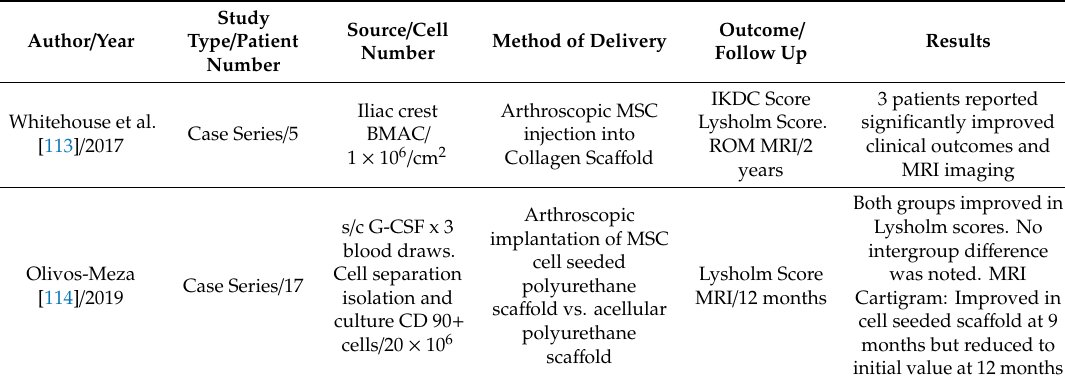
Table 5. Summary of clinical studies using tissue